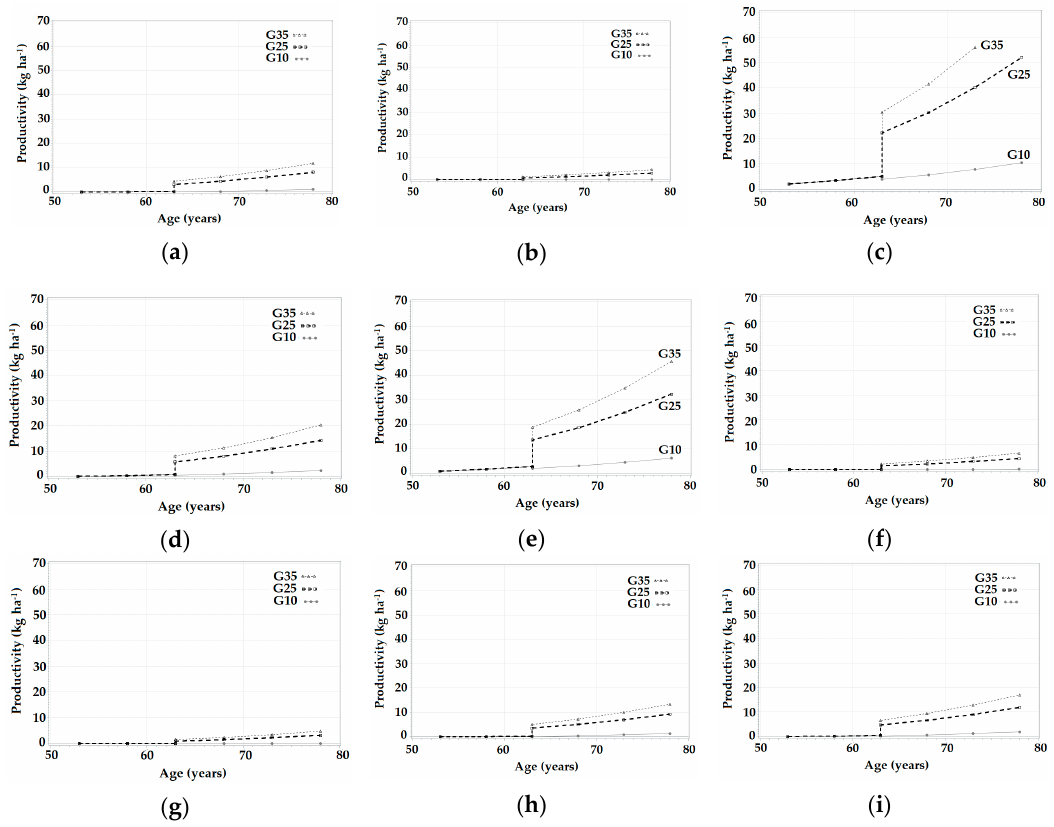
Figure 3. Total mushroom productivity by silvicultural scenarios for the c1 ( a ), c2 ( b ), c3 ( c ), c4 ( d ), c7 ( e ), c10 ( f ), c13 ( g ), c16 ( h ) and c18 ( i ) climate scenarios.